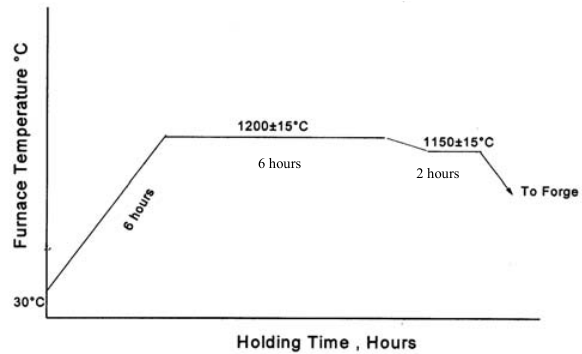
Figure 1. Schematic diagram showing homogenization and forging process